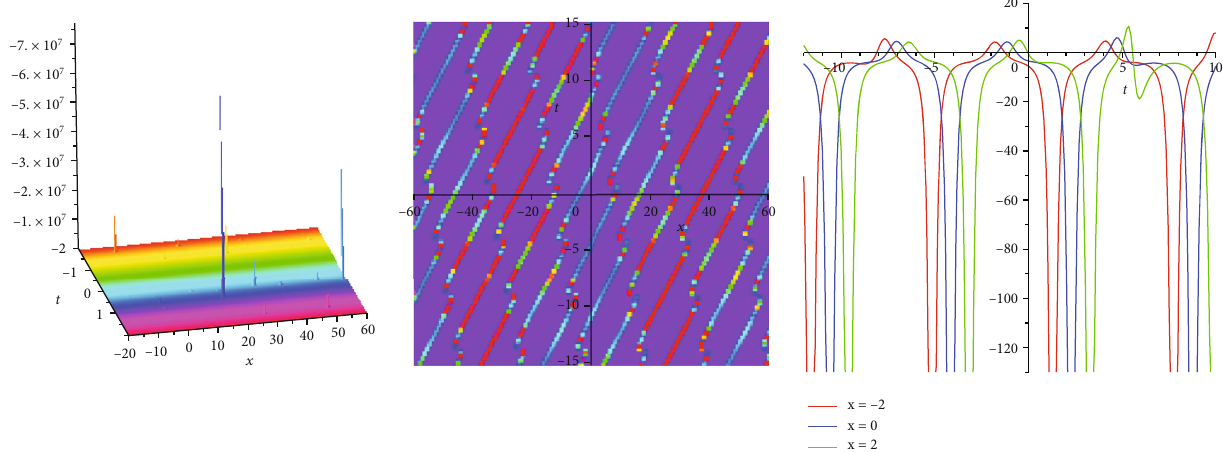
Þ (3D plot, density plot, and 2D plot t ), respectively. 5